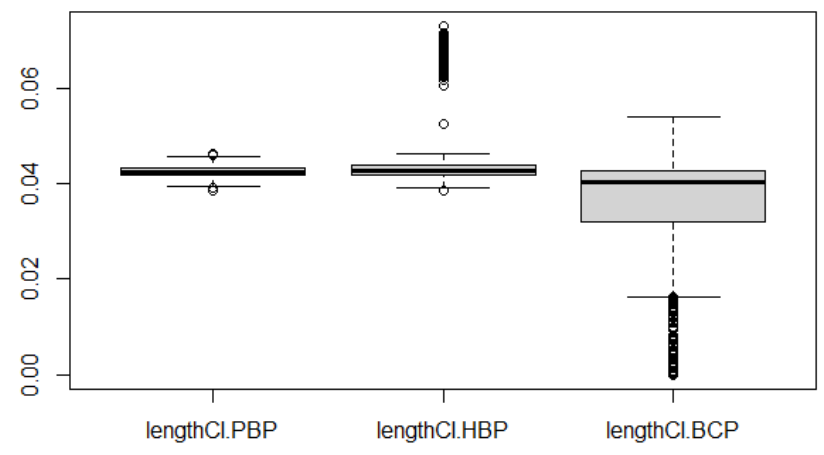
Figure 3. The box plots of bootstrap confidence intervals based on the PBP, HBP and BCP methods for the mixture GR distributions.